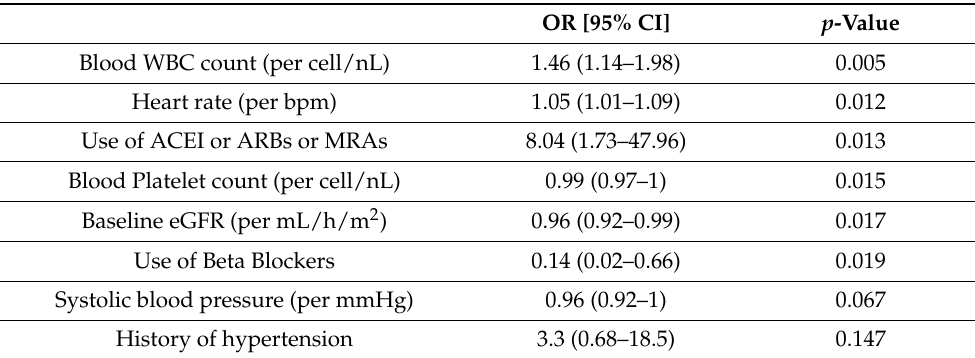
Table 4. Results of multivariate logistic regression for the effect of various covariates on acute kidney injury incidence in patients with high grade AV